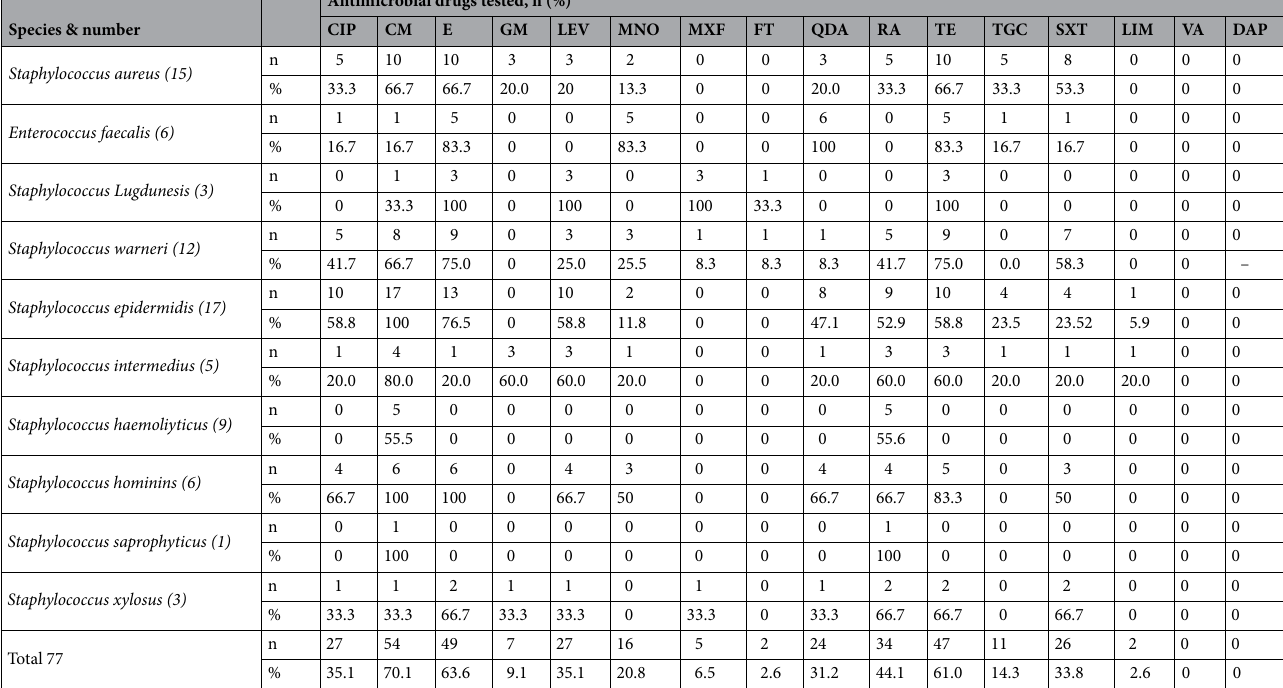
Table 4. Percentage antimicrobial resistance profile of blood-born Gram-positive bacteria. CIP ciprofloxacin, CM clindamycin, E erythromycin, GM gentamicin, LEV levofloxacin, MN0 minocycline, MXF moxifloxacin,